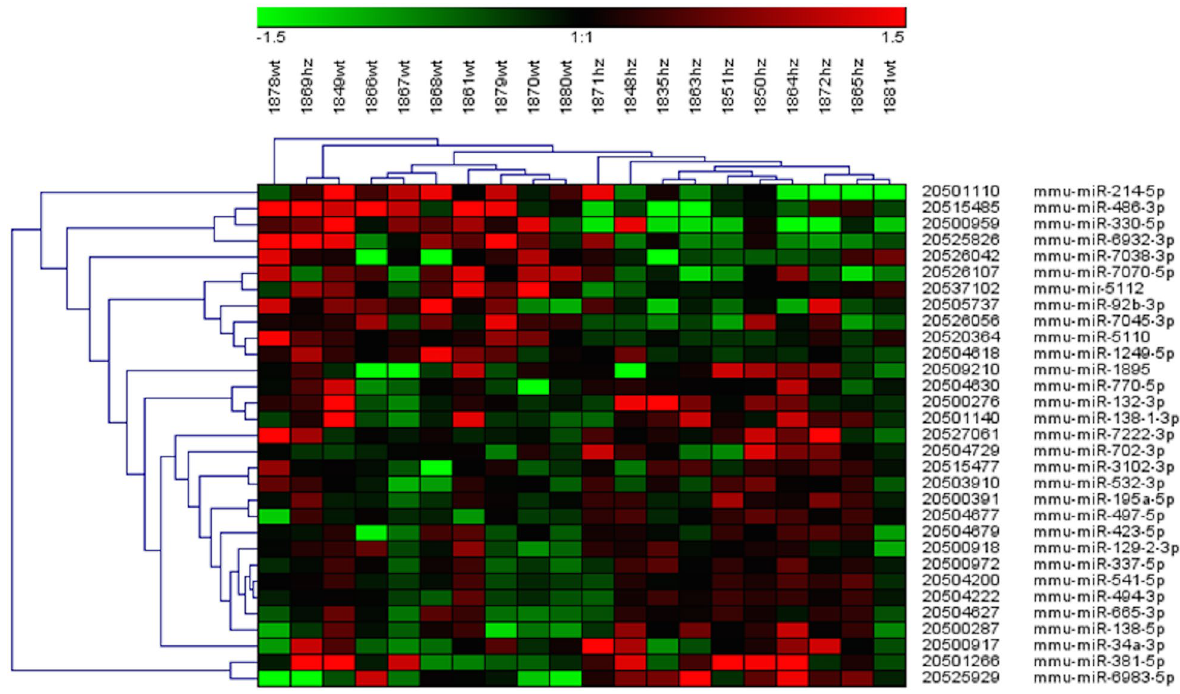
Figure 2. Bidirectional hierarchical clustering and heat map of the 31 significantly differentially expressed miRNAs using software